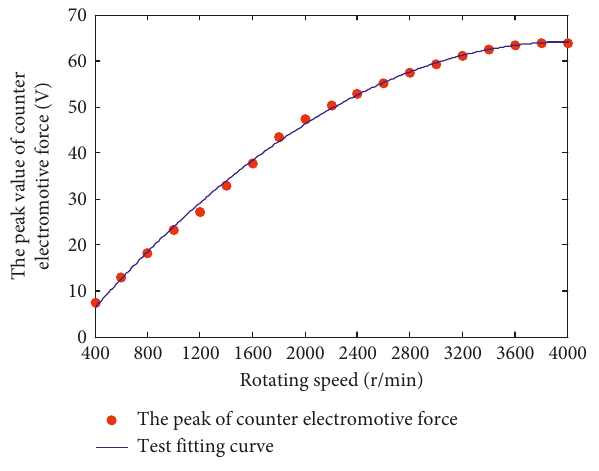
Figure 6: The peak value curve of counter electromotive force of the motor. Figure 7: The motor back-EMF coefficient curve.